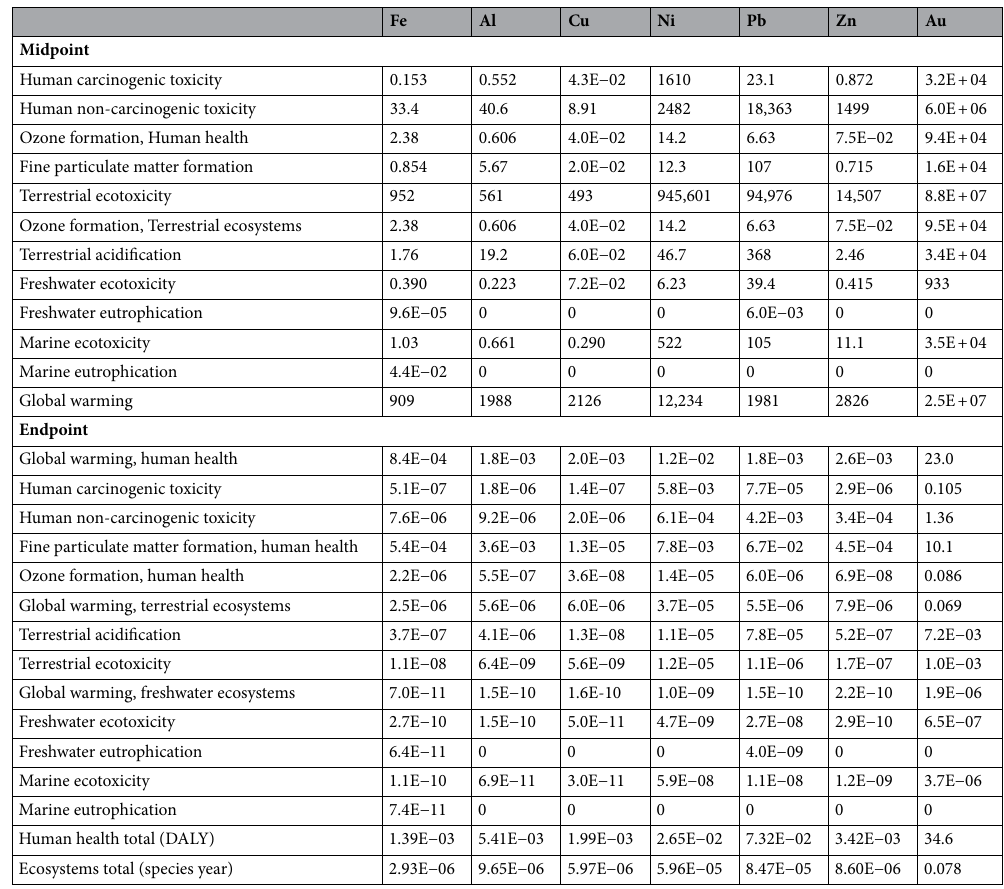
Table 4. Environmental impact assessment of metal producing industries expressed on per tonne of produced metal.